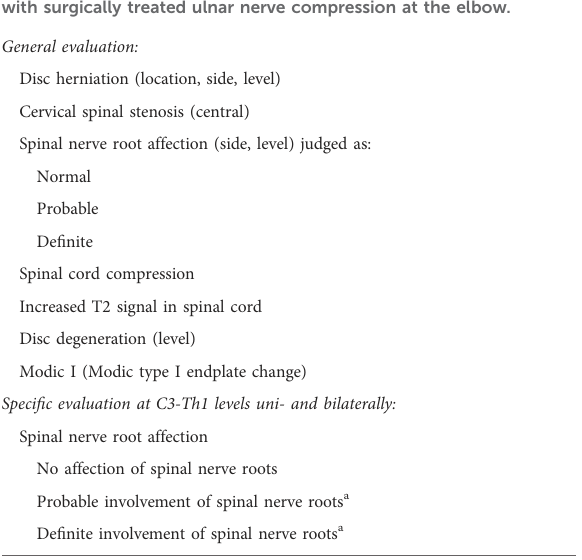
TABLE 1 De fi nition of assessment of the MRI images in 62 patients with surgically treated ulnar nerve compression at the elbow. General